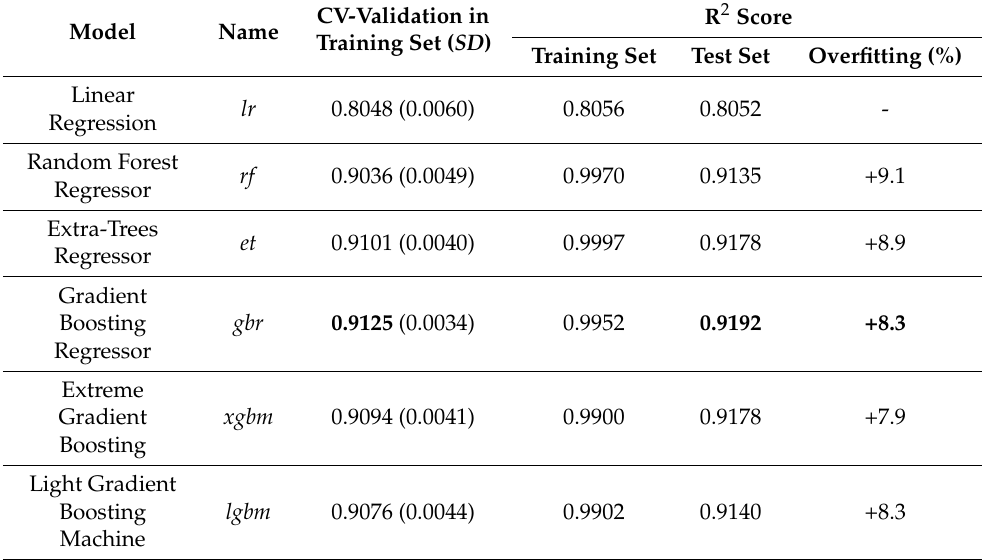
Table 5. Performance results of the trained algorithms (R 2